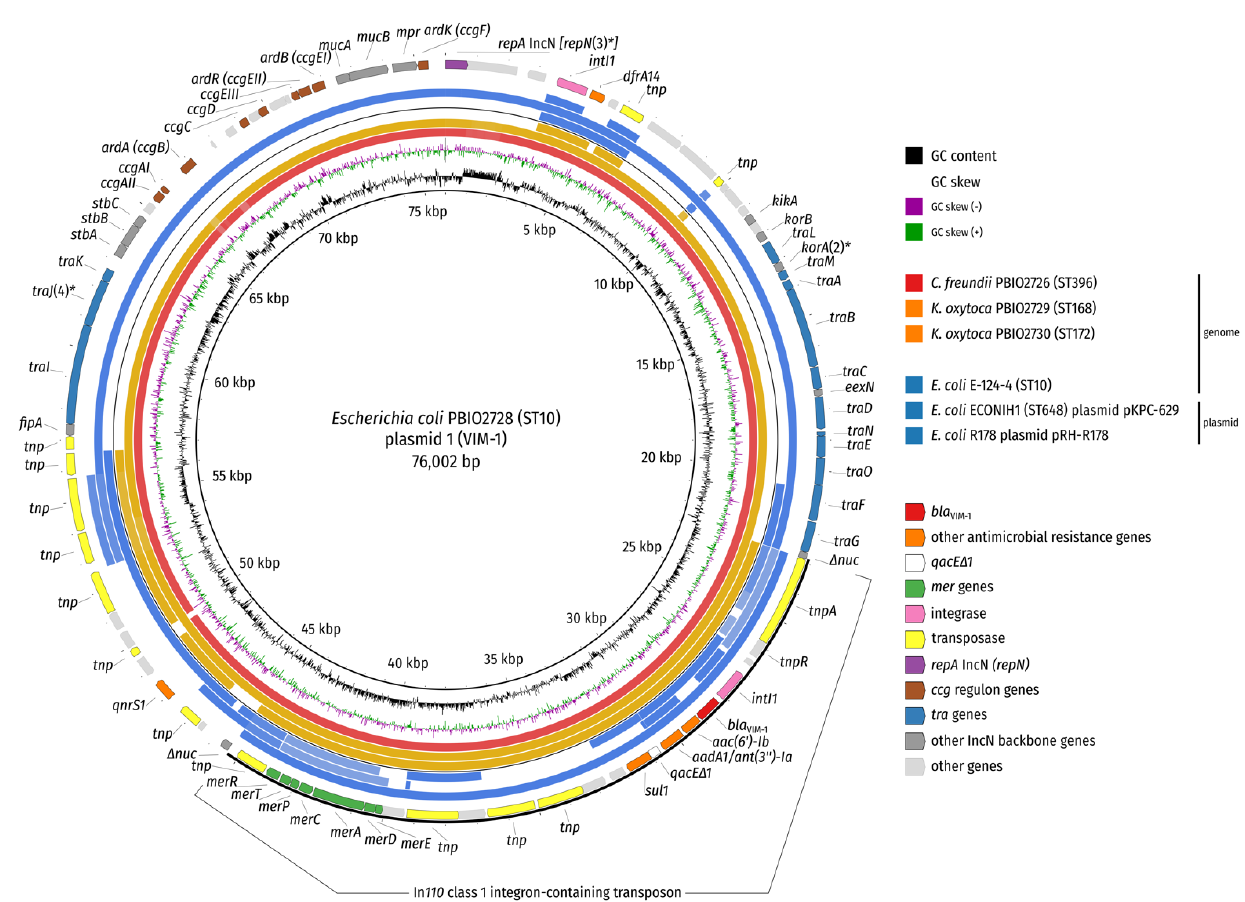
Figure 1. BLAST comparison of plasmid 1 (pPBIO2728_VIM-1). The genomes from this study (three inner circles) and sequences from a public genome ( E. coli E-124-4, NCBI accession NZ_PDDP00000000.1) and two plasmids ( E. coli ECONIH1 plasmid pKPC-629, NCBI accession CP009862.1; E. coli R178 plasmid pRH-R178, NCBI accession HG530658.1) (three outer rings) were compared by BLAST (-task megablast -evalue 1e-10 -dust no). Concentric rings are colored by species. The outermost ring shows coding sequences (CDS; colored according to legend) with various common IncN sequence features (e.g., CUP [Conserved Upstream]-controlled genes [ ccg ] [29]) labelled by gene name. The asterisks denote alleles of the IncN pMLST scheme, which match ST7. Note that all isolates in this study and only E. coli E-124-4 and E. coli R178 carry the bla VIM-1 resistance gene. The mercury resistance operon, however, was present in all analyzed sequences.